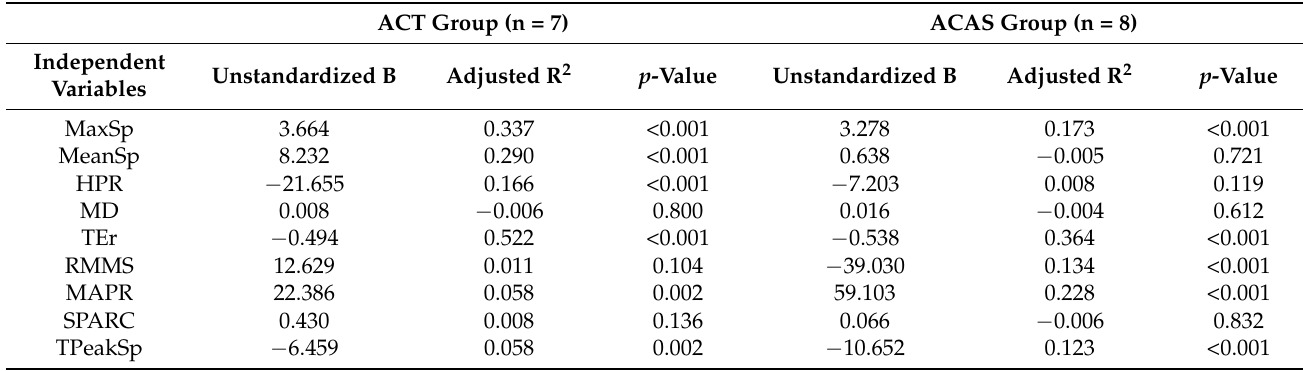
Table 4. Comparison of simple linear regression analysis of independent kinematic features for FMA-UE in the ACT and ACAS